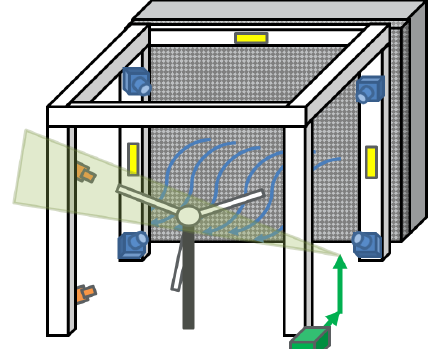
Figure 2. Schematic diagram of measurement